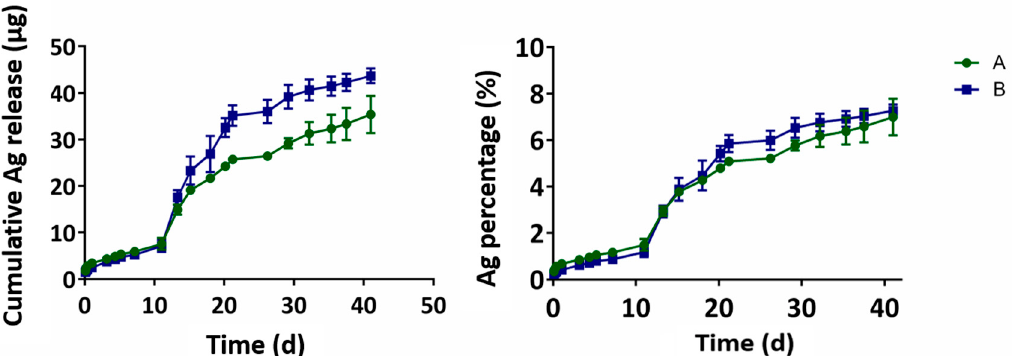
Figure 11. Release kinetics of A and B during 40 days in DMEM medium.